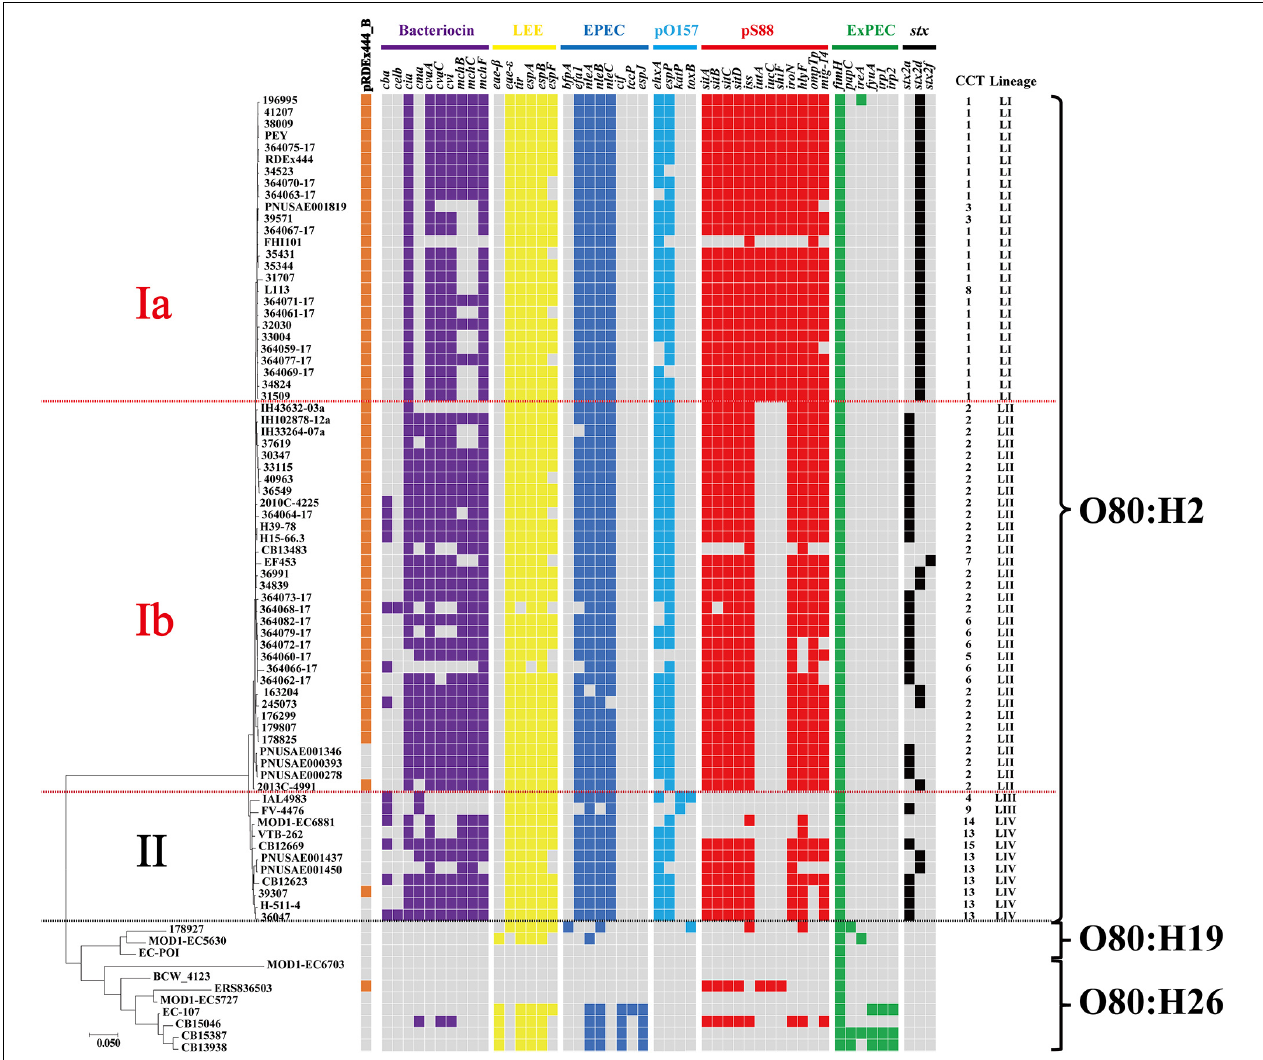
FIGURE 5 | Phylogenetic relationship of all O80 strains based on wgSNPs analysis using CSI Phylogeny 1.4 on the CGE server. Presence of virulence genes or plasmid pRDEx444_B are indicated in cell colors: gray (absence) and brown, purple, yellow, steel blue, light blue, red, green, and black (presence). Genes related to bacteriocin are indicated in purple. Virulence genes related to LEE are indicated in yellow, and virulence genes related to EPEC but not related to LEE are indicated in steel blue. Virulence genes related to pO157 and Shiga toxin are indicated in light blue and black, respectively. Virulence genes related to pS88 are indicated in red, and virulence genes related to ExPEC but not related to pS88 are indicated in green. The CT and CRISPR lineage of each strain are indicated on the right